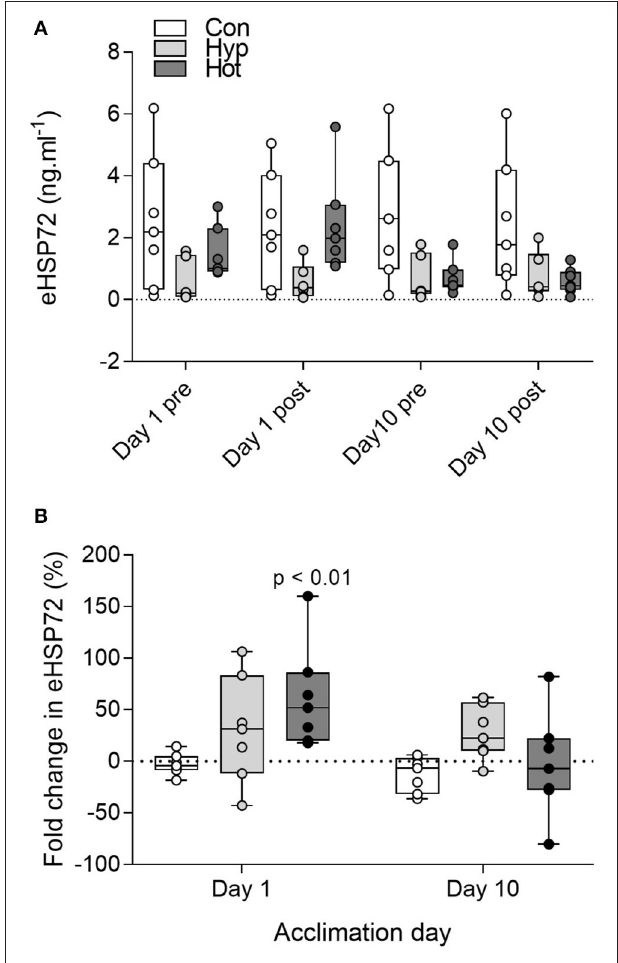
FIGURE 3 | Extracellular HSP72 before and after exercise on day 1 and day 10 of the acclimation intervention for all individual participants (A) ; and percent change in eHSP72 from pre to post-exercise on day 1 and day 10 of acclimation (B) . Box plots show all individual data points (dots), the 25 and 75th interquartile ranges (boxes), and the median (mid-line). Whiskers illustrate the highest and lowest value. For display purposes one participant with high eHSP72 values is not included in panel A (day 1 pre, 17.8 ng . mL − 1 , day 1 post, 24.4 ng . mL − 1 ; Day 10 pre, 15.6 ng . mL − 1 , Day 10 post, 19.1 ng . mL − 1 ). P -values indicate differences relative to pre-trial resting values within each experimental group (B)